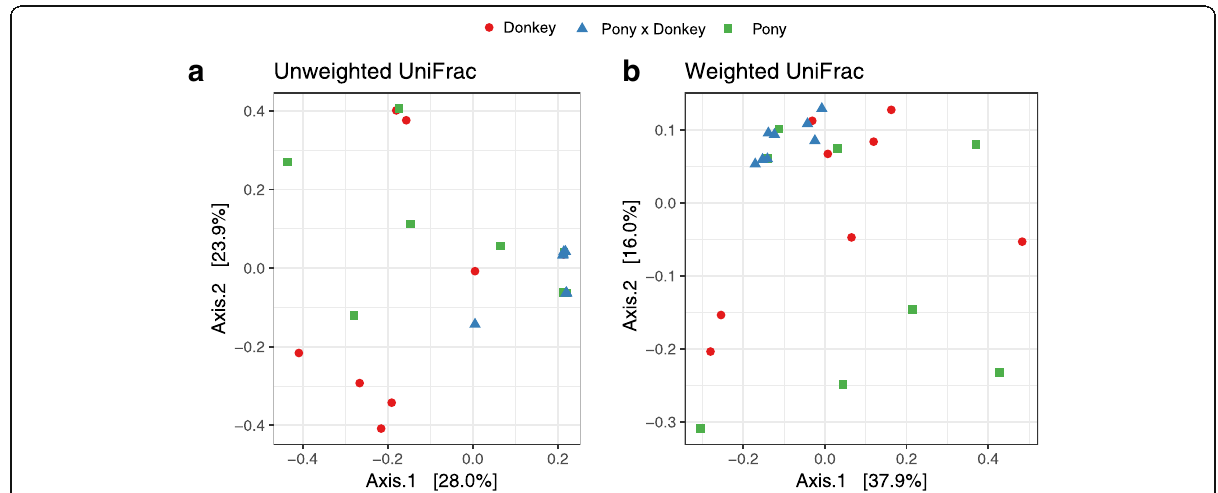
Fig. 4 Unweighted ( a ) and weighted ( b ) UniFrac based principal co-ordinates analysis of the fecal anaerobic fungal community composition of the different equine types at the OTU level. Analysis used Log 10 transformed data, and the percentages values labelled on each axis indicate the amount of total variation